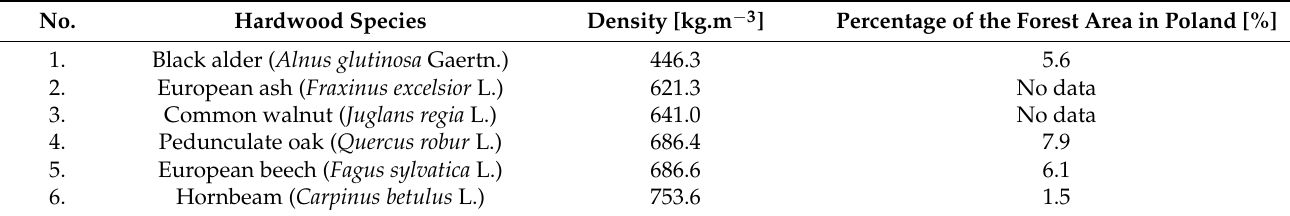
Table 1. Density of the hardwood species used in this research